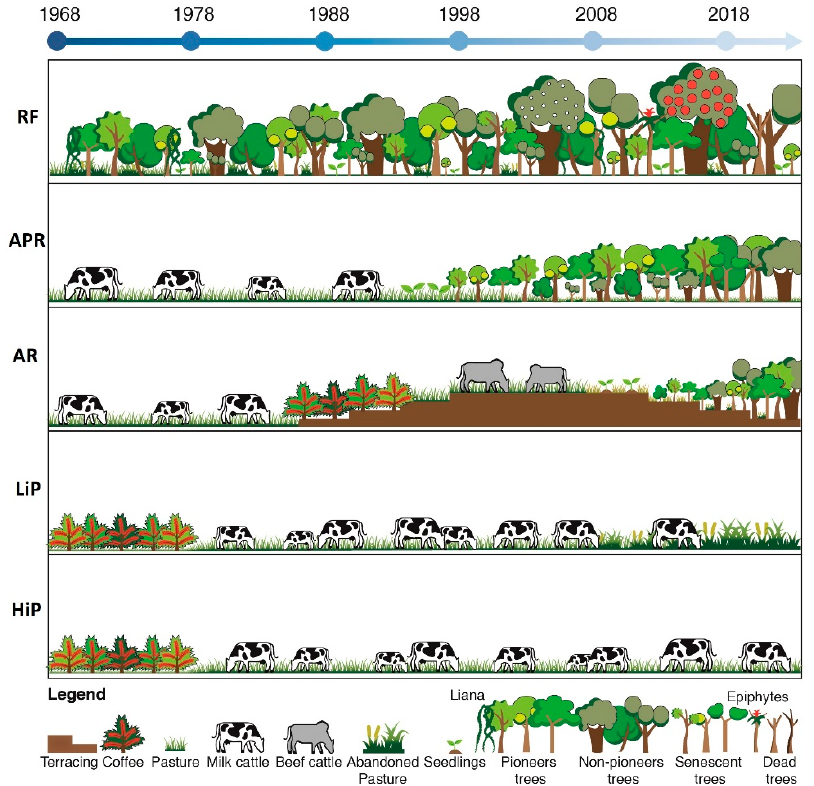
Figure 3. Land use history for each land use type. RF, Reference Forest; APR, Assisted Passive Restoration; AR, Active Restoration; LiP, Low-intensity Pasture; HiP, High-intensity Pasture.